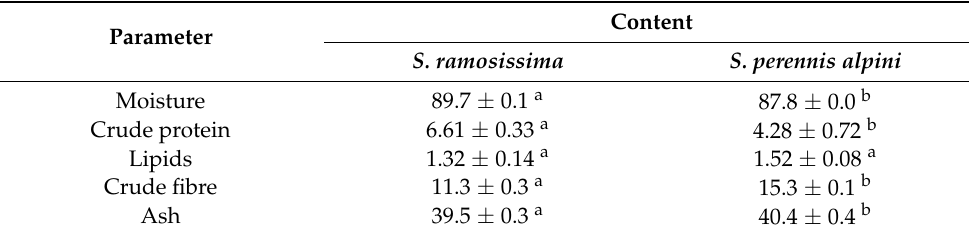
Table 1. Moisture (% fw) and nutrient composition (% dw) of Salicornia ramosissima and Sarcocornia perennis alpini (mean ± SD; n =